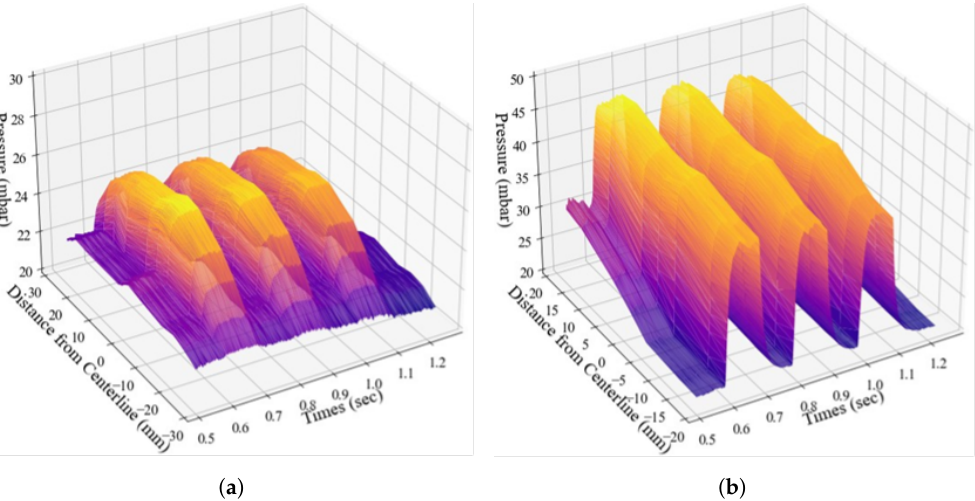
Figure 7. Time series across Row 2 of pressure taps as labeled in Figure 2b. Data is shown for three consecutive plasma pulses, each with duration 100 ms on followed by 100 ms off. Comparison of pressure redistribution at P 0 = 2.6 bar between ( a ) single filament and ( b ) three filaments